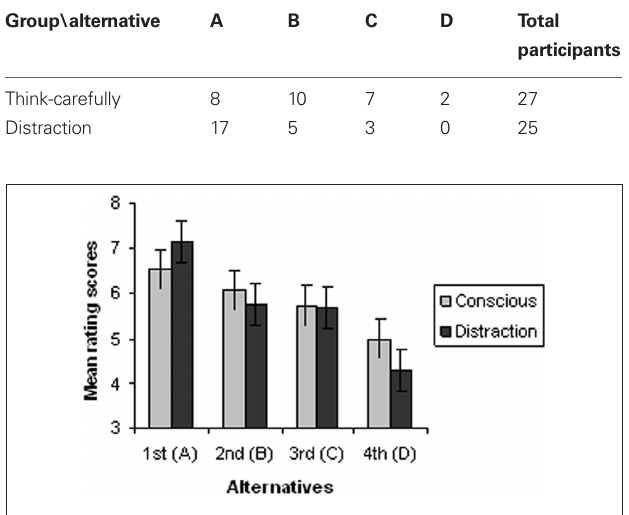
FiGuRE 1 | Mean evaluations for the four alternatives in the two groups (A is best option, D is